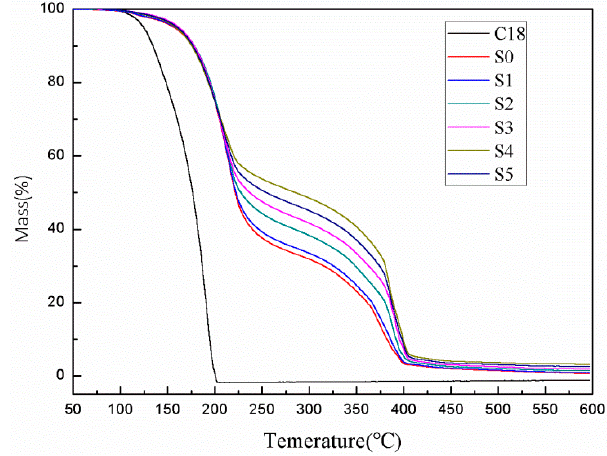
Figure 7. Thermogravimetry spectra of C18, S0, S1, S2, S3, S4, and S5.